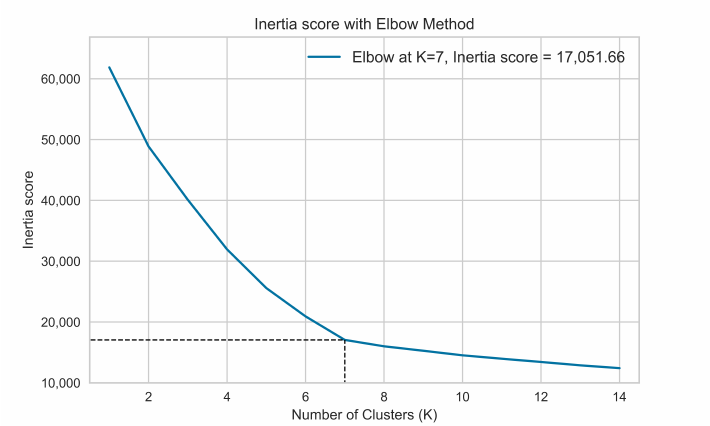
Figure 8. Evaluation of the optimal number of clusters.